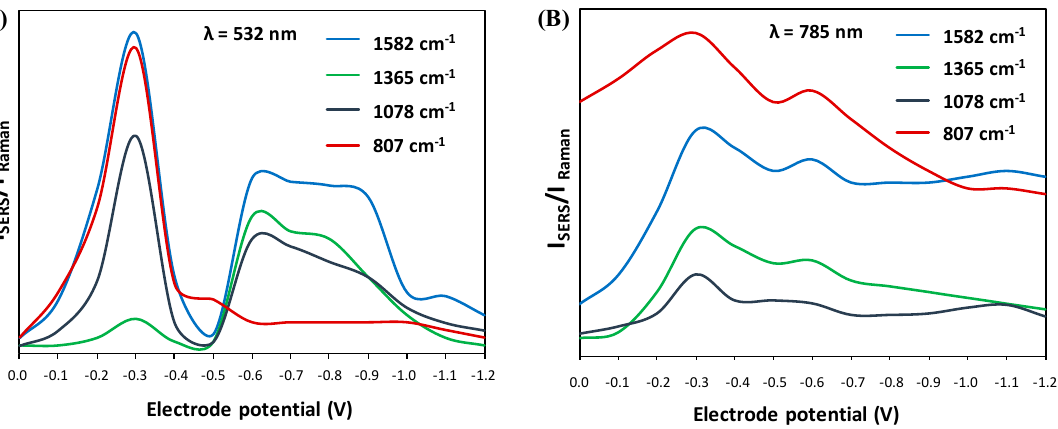
Figure 4. SERS excitation CT profiles of selected bands vs. the electrode potential generated for 532 nm ( A ) and 785 nm ( B ) excitation lines.